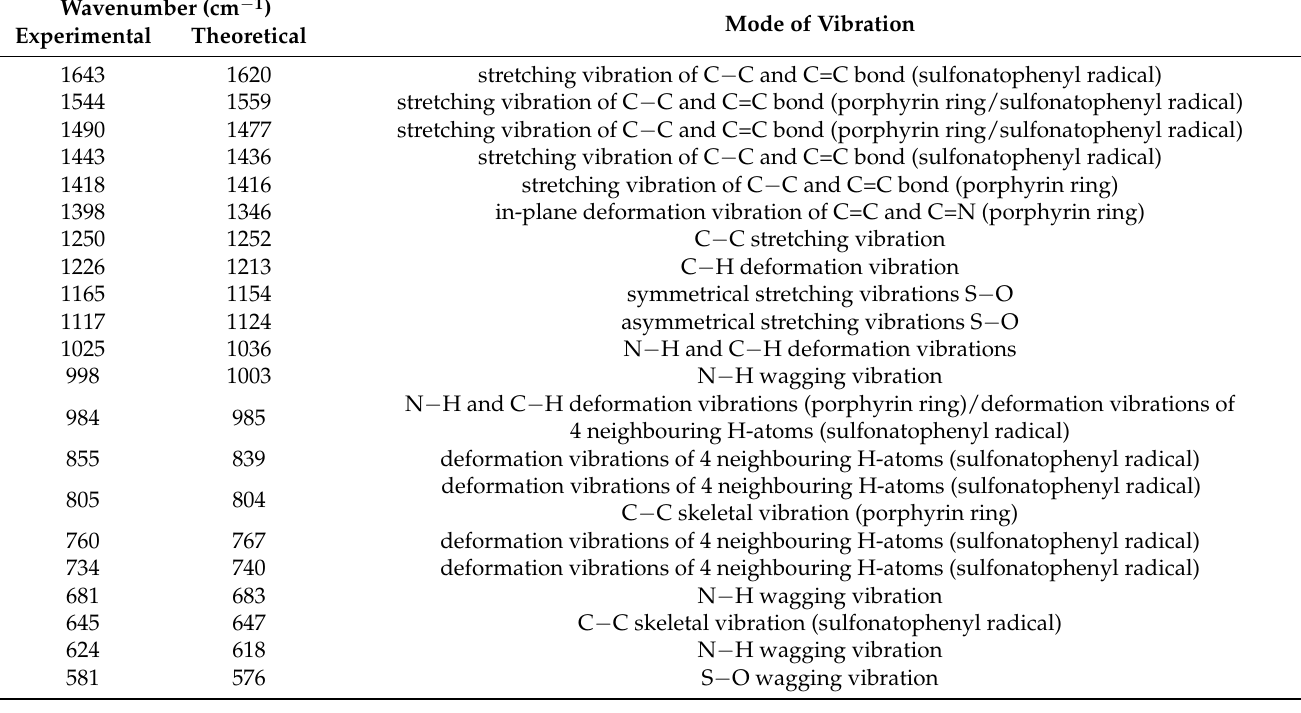
Mode of Vibration